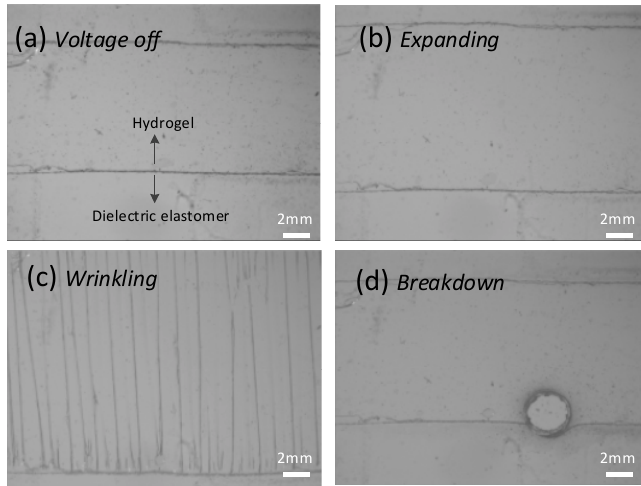
Figure 4. Actuation and wrinkling of the hydrogel via a dielectric elastomer. ( a ) Without a voltage, it is flat. ( b ) With a low voltage, the gel and elastomer expand. ( c ) Upon a critical voltage, the gel wrinkles. ( d ) As the voltage ramps, the actuator fails at breakdown.